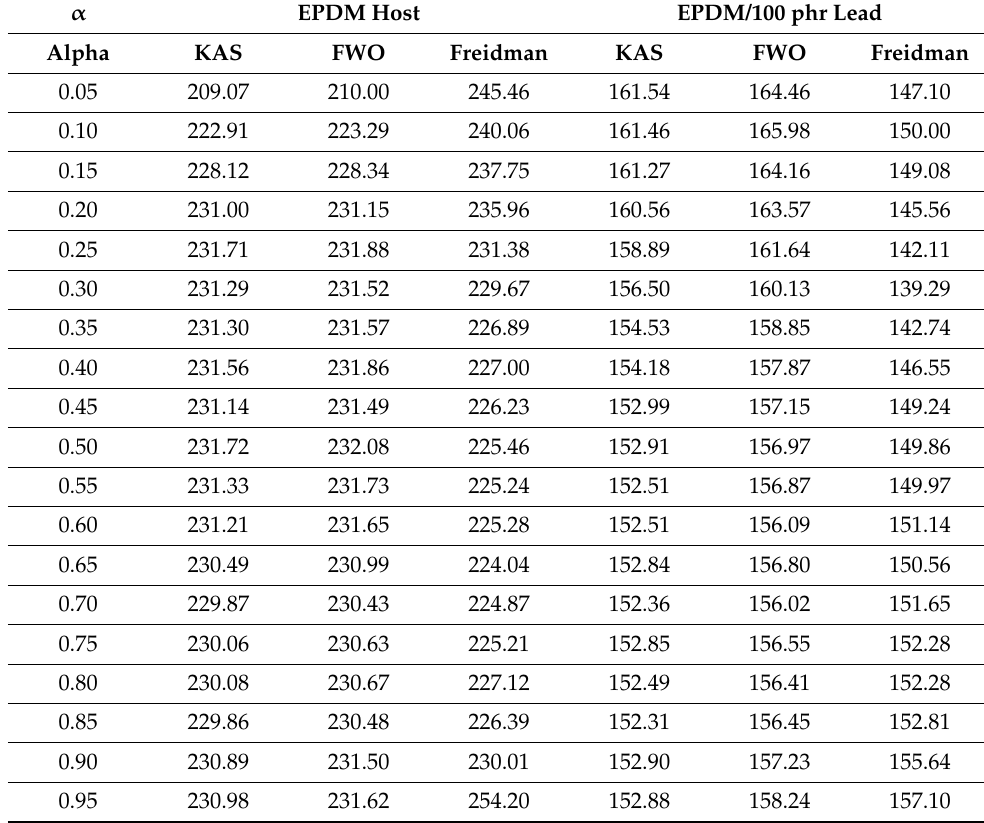
Table 5. The activation energy values calculated using three methods for the host composite (0 phr lead) and composite loaded with 100 phr